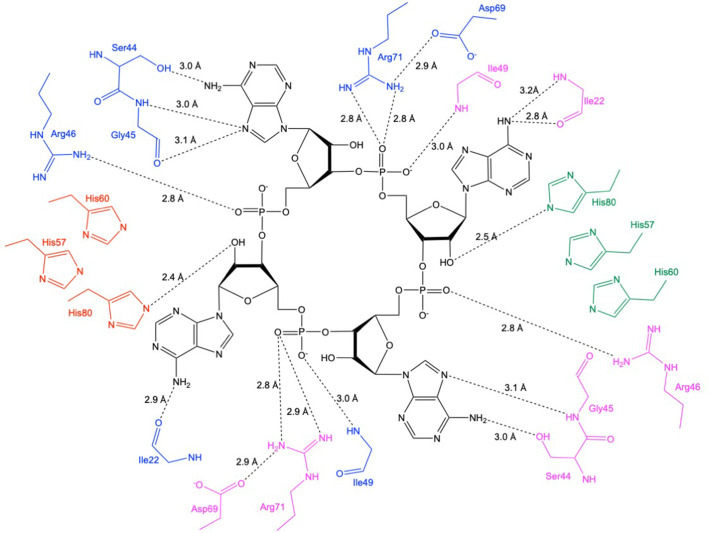
Schematic showing interactions between Csx3 and cA4.The residues in blue and pink represent the two monomers in the dimer constituting the ‘D69 face’, and the residues in green and red represent the two monomers in the dimer constituting the ‘H60’ face. Whilst H60 was not present in our structure, the position has been inferred by superposition with PDB 3WZI.